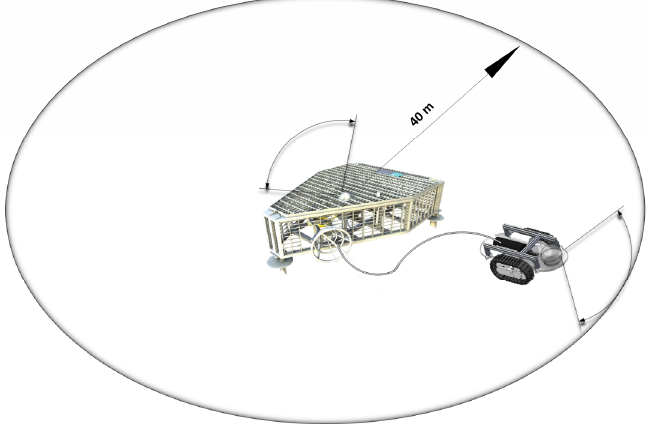
Figure 12. The limited OBSEA underwater observatory monitoring area, expanded by the underwater crawler. Table 2. The number of individuals for each taxon (and densities per m 3 in parentheses) as identified with the OBSEA and crawler cameras during the testing period. OTU refers to visible but not classified